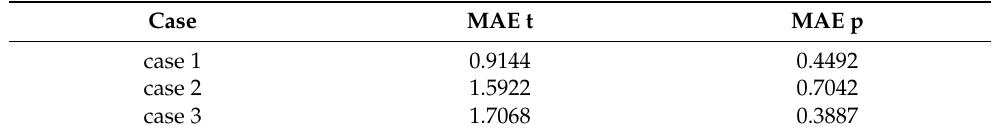
Table 2. MAE for three cases on the test